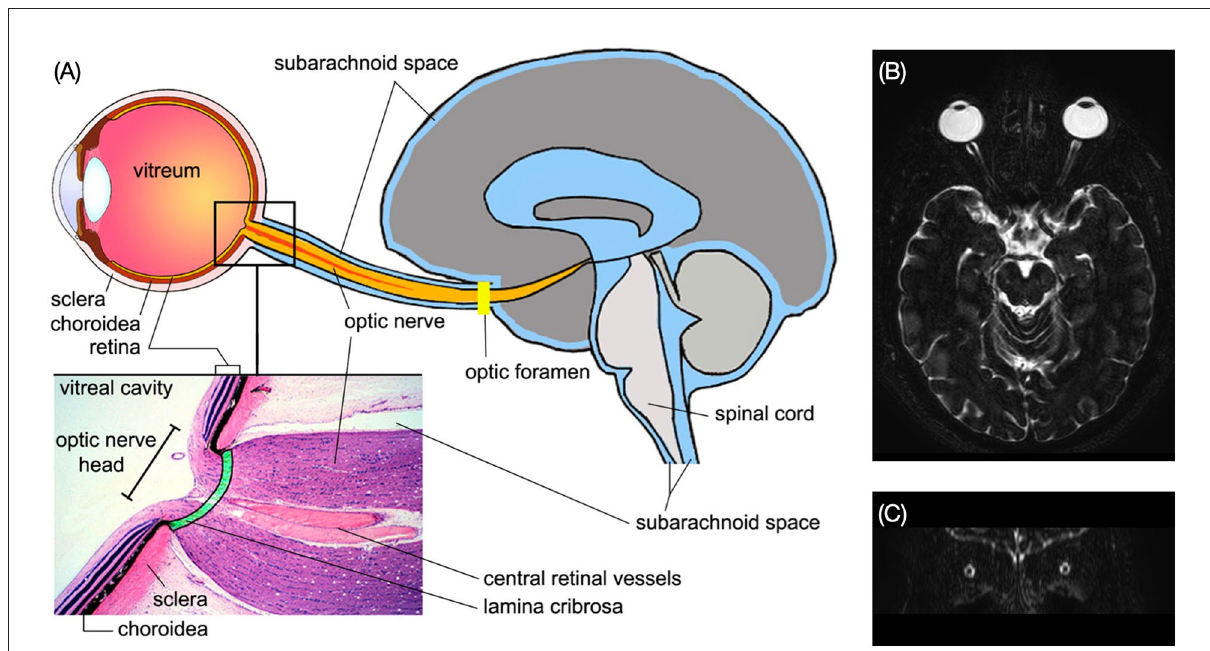
FIGURE5 (A) Structure of the subarachnoid spaces of the ON and the brain. Enlarged view shows the structure of the ON head [Reproduced from Wostyn et al. (29) with permission]. (B) Axial MRI image of the brain shows the ON subarachnoid space in bright signal. (C) The ON subarachnoid space in coronal plane (Credit: Quan V.